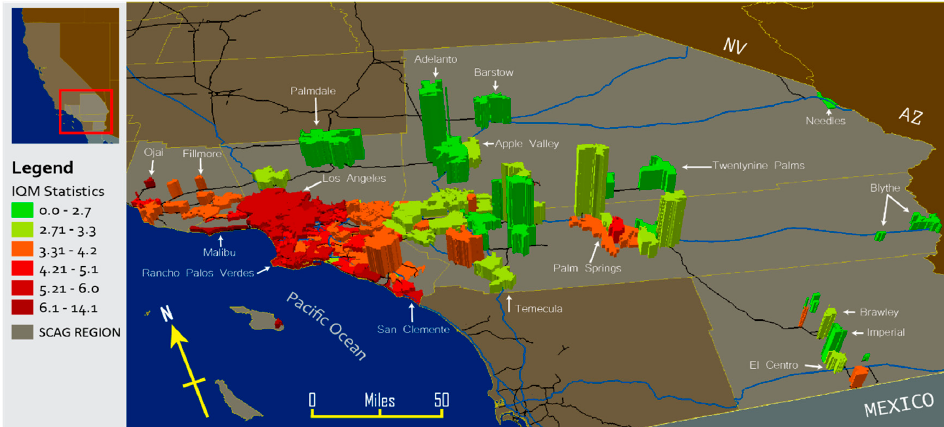
Figure 5. Map of the Los Angeles Region Cities by IQM statistics. This map illustrates the cities that were assigned high housing growth (i.e., Adelanto, Barstow, Blythe, Brawley, and Palmdale) were also outlying and the region’s most affordable. Note: IQM = informal qualification metric. The extrusion heights are not to scale. Source.